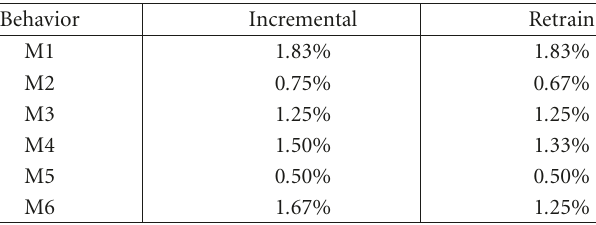
Figure 11: Confusion occurrence for the retraining